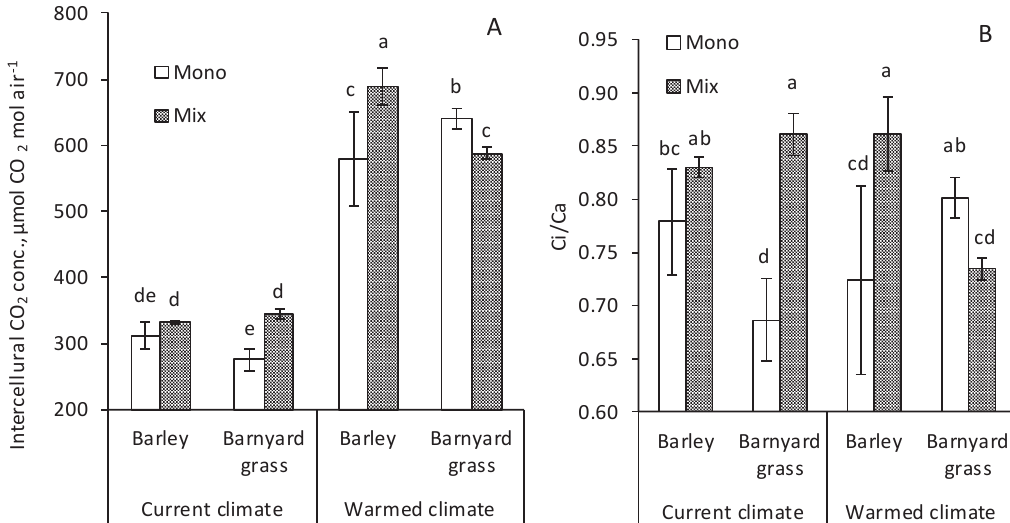
Fig. S 1. The changes of intercellular CO2 concentration (A) and the intercellular-to-ambient CO ratio (B) in barley ( Hordeum vulgare L.) and barnyard grass ( Echinochloa crus-galli L.) plant leaves grown in mono culture (Mono; 15 plants per pot) and mix culture (Mix; 9 crop plants and 6 weeds) under the current climate (400 µmol mol -1 CO ; day/night temperatures 21/14 °C) and the warmed climate (800 µmol mol -1 CO 2 conditions. Each value represents the mean ±CI (n=3). Different letters indicate significant differences at p <0.05 between the treatments as determined by Least Significant Differences (LSD) test.